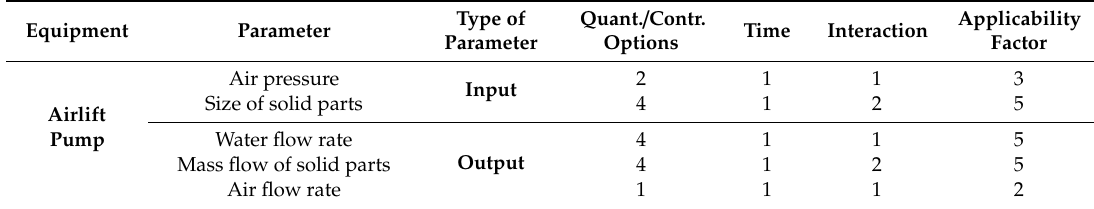
Table 8. Evaluation parameters of the airlift pump.